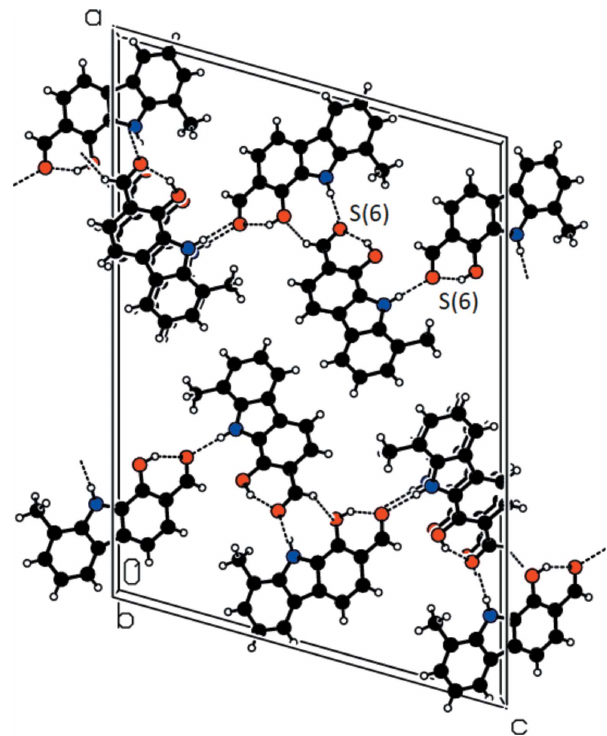
Figure 3 Perspective partial packing view of the title compound, viewed along the b axis, showing the hydrogen-bonding interactions. Black dashed lines indicate the N—H (cid:2)(cid:2)(cid:2) O, O—H (cid:2)(cid:2)(cid:2) O and C—H (cid:2)(cid:2)(cid:2) O hydrogen